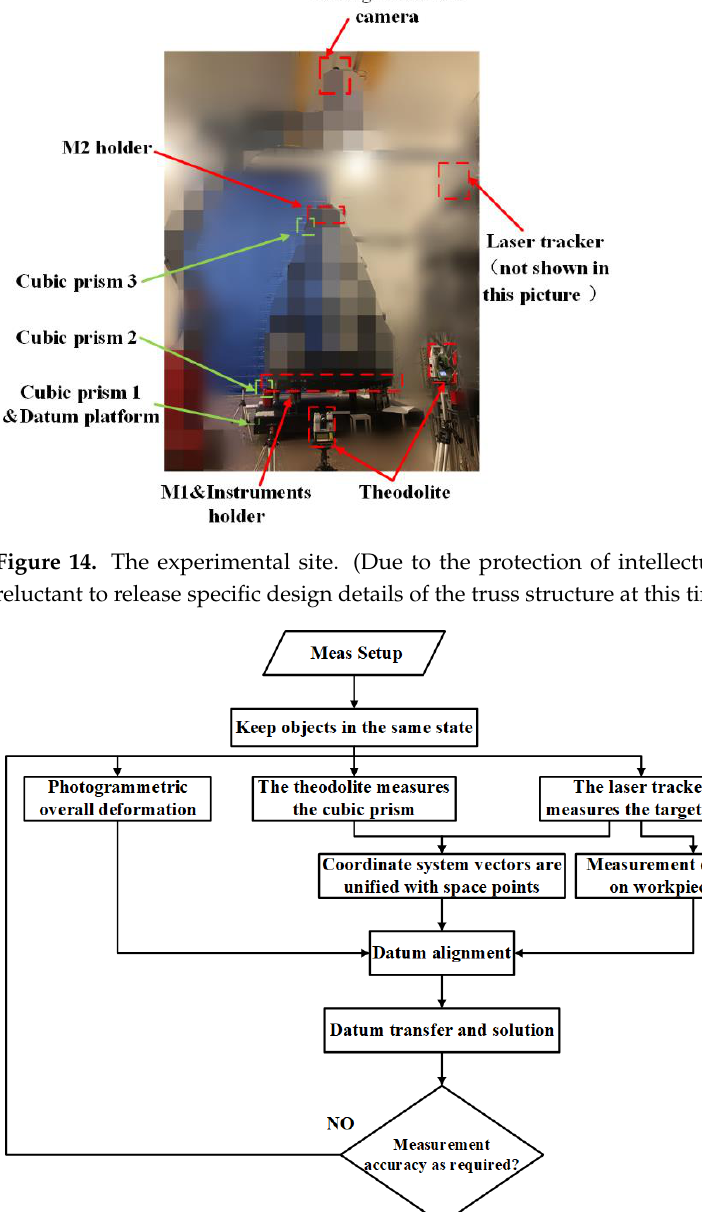
Figure 14. The experimental site. (Due to the protection of intellectual property rights, we are reluc- tant to release specific design details of the truss structure at this time.).